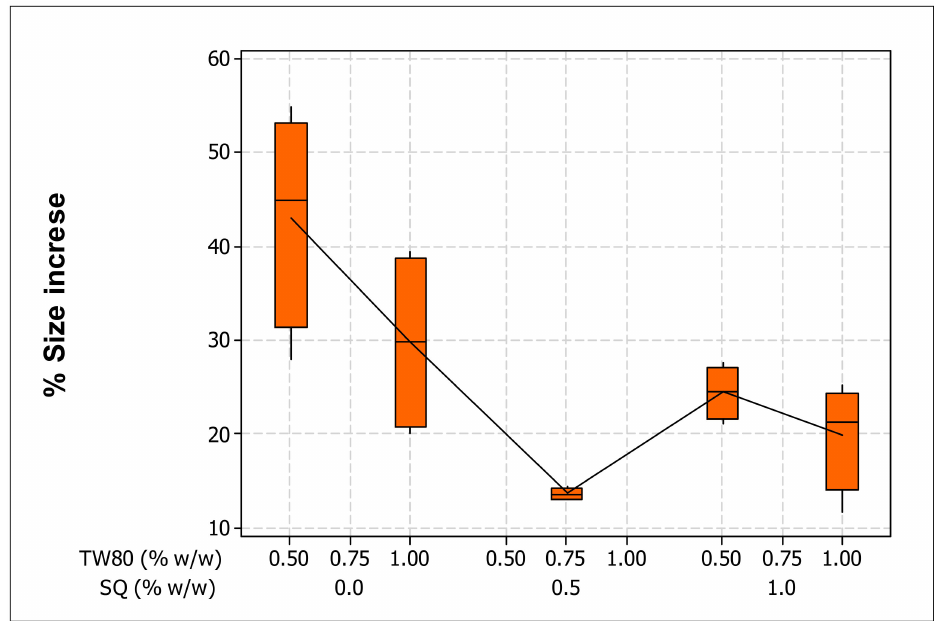
Figure 1. Size increase (%) of the prepared liposomes after UV exposure (280–320 nm, 6 h) a ff ected by the e ff ect of squalene (SQ) and Tween80 (TW80)